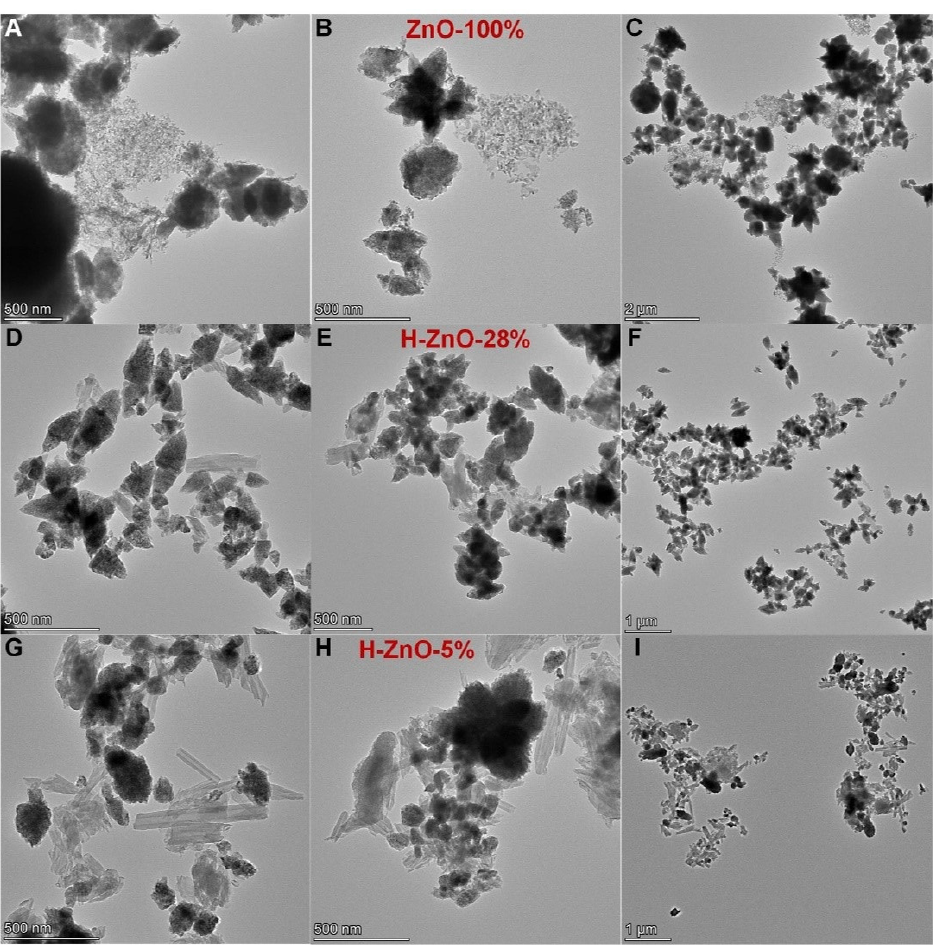
Figure 4. TEM images of the investigated samples, ( A – C ): synthetic ZnO-100%, ( D – F ): H-ZnO-28%, and ( G – I ):